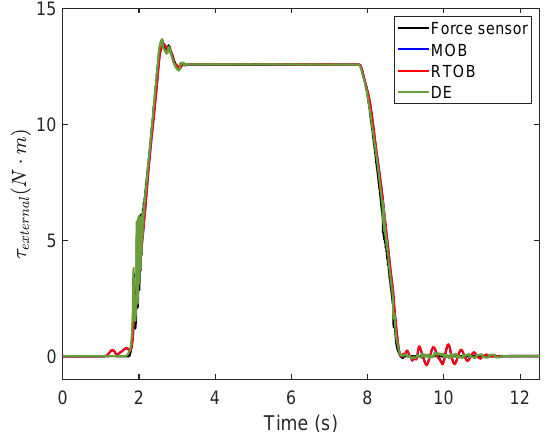
Figure 16. The result of external torque estimation.